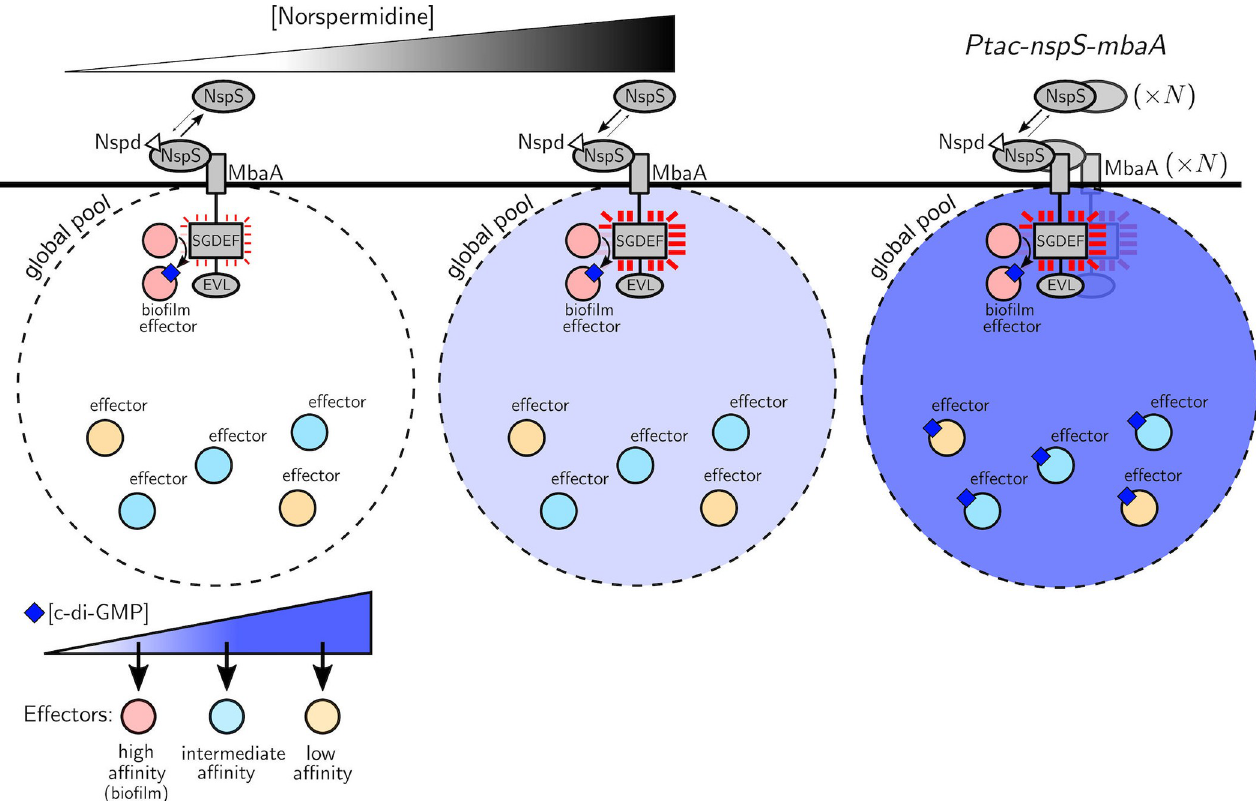
Fig 7. Model for local and global c-di-GMP signaling for the NspS-MbaA pathway in V . cholerae . At low norspermidine concentrations, NspS-MbaA transmits c-di-GMP directly to particular high affinity biofilm effectors via a local mechanism. This local mechanism sensitizes V . cholerae to norspermidine. At high norspermidine concentrations, when the NspS-MbaA diguanylate cyclase activity is maximal, the level of c-di-GMP that MbaA produces surpasses the amount that can be accommodated in the local pool. The extra c-di-GMP is contributed to the global pool and in principle becomes accessible to additional effectors. However, as shown in the results in Fig 6, only the subset of transcription effectors with the highest affinity for c-di-GMP, i.e., those regulating biofilm gene expression, detect these low-level changes to the global c-di-GMP pool. In the case of NspS-MbaA signaling, it appears that this subset of effectors is saturated by the local signaling mechanism. Thus, specificity in biofilm gene expression output is retained across all norspermidine ligand levels (Fig 6). Under artificial conditions, such as overexpression of nspS and mbaA by Ptac , the global c-di-GMP pool is driven higher, lower affinity effectors that control genes other than those involved in biofilms are engaged, and gene expression output specificity is